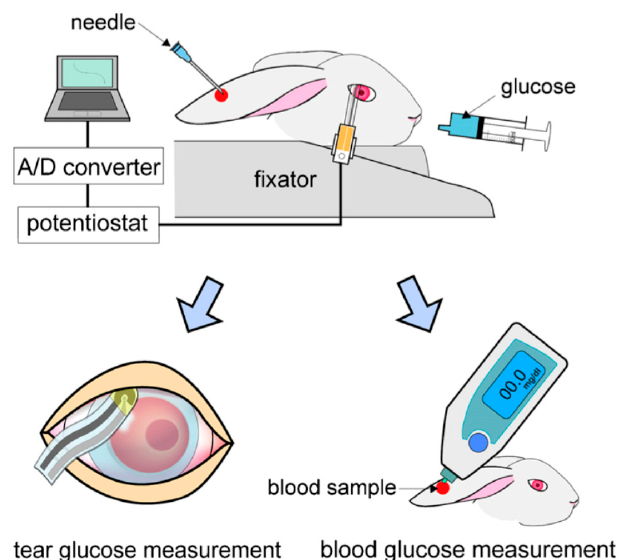
Figure 5. Measurement method of tear glucose concentration with a contact lens biosensor. BG levels were simultaneously measured by a commercial BG monitoring kit. Reprinted with permission from [69].